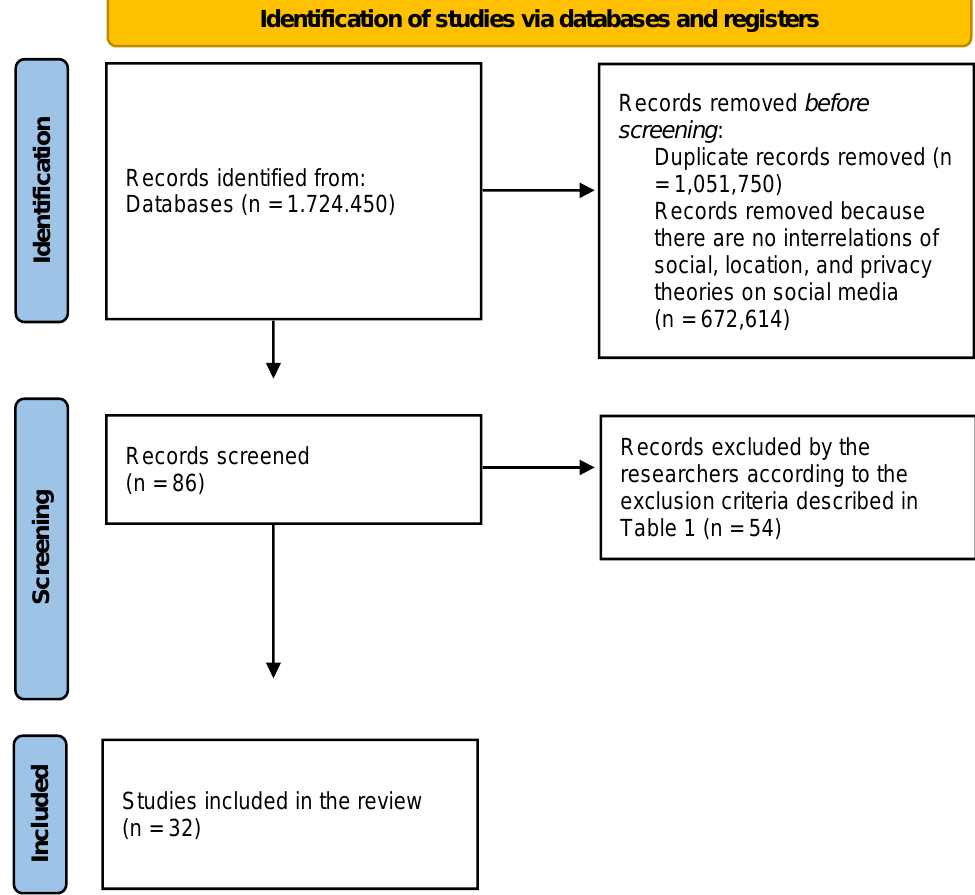
Figure 1. Methodology processes: Prisma 2020 flow diagram.